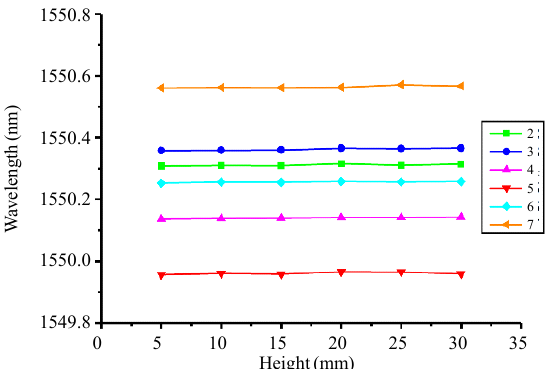
Fig. 10 Wavelength shift of six side cores versus the pushing height after compensation of central